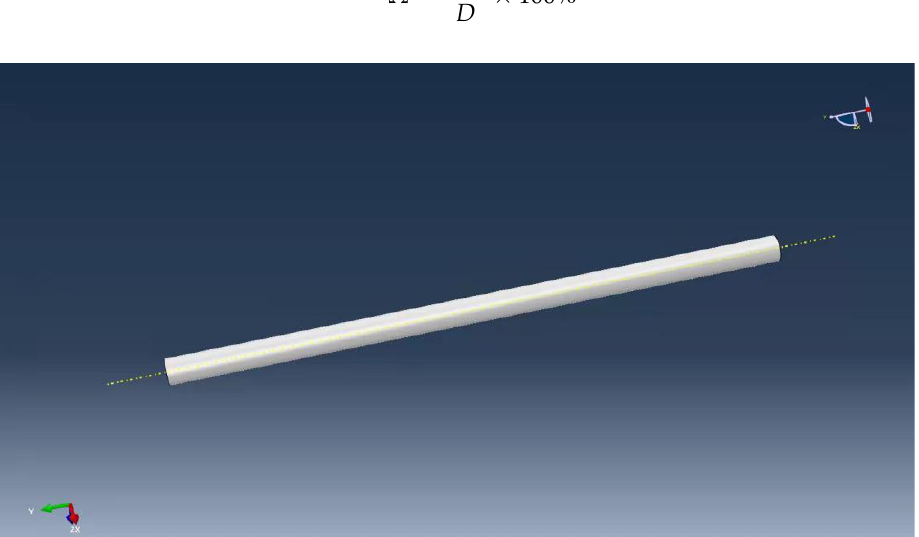
Figure 1. The finite element model of the submarine pipeline.